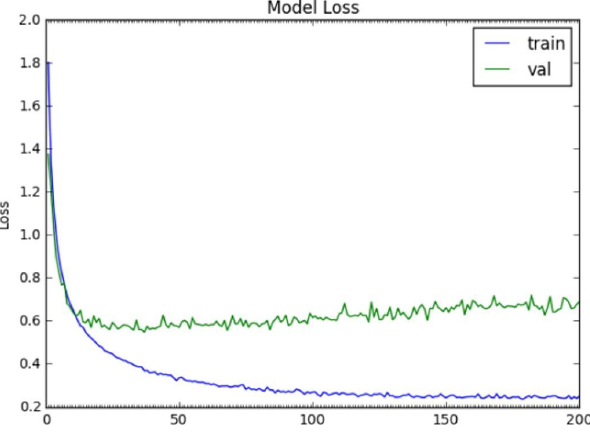
Figure 6. Accuracy and loss plot on training and validation